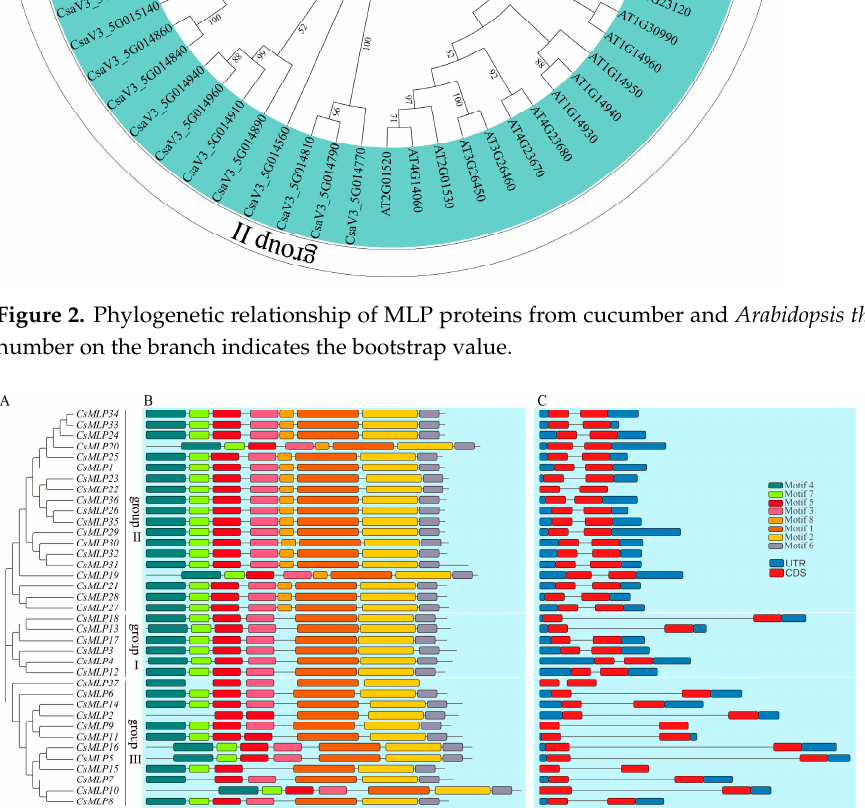
Figure 2. Phylogenetic relationship of MLP proteins from cucumber and Arabidopsis thaliana . The number on the branch indicates the bootstrap value.